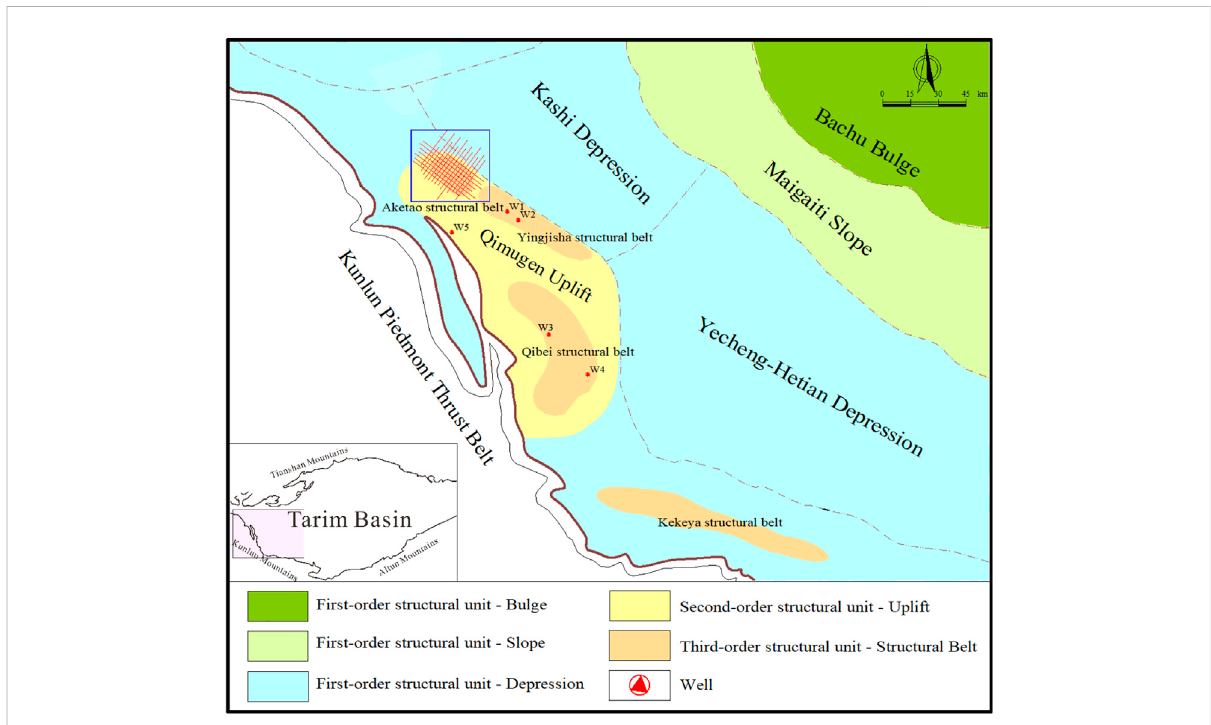
FIGURE 1 Location and seismic line distribution of the Aketao structural belt in the piedmont zone of Southwest